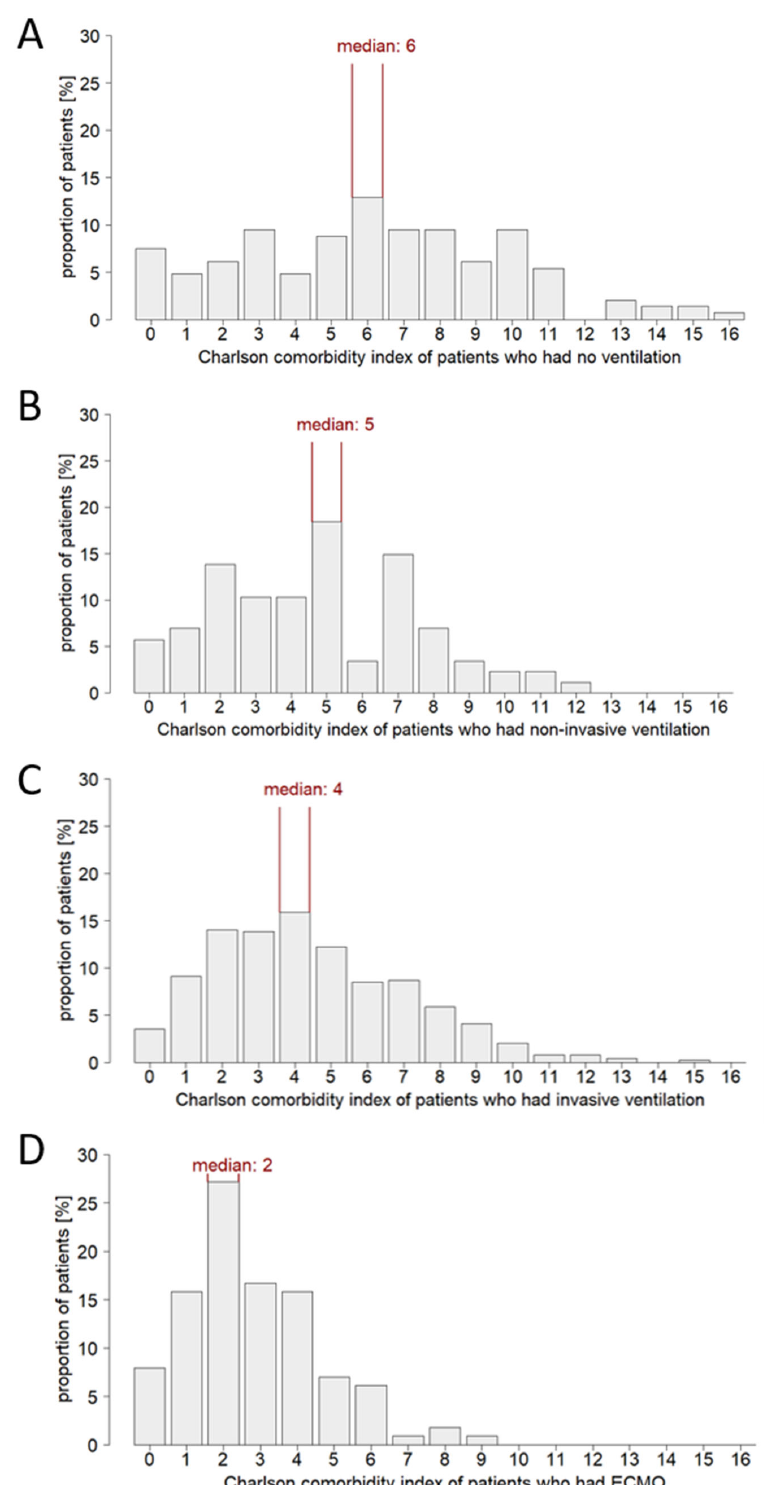
Figure 3. Distribution of the Charlson comorbidity index in COVID-19 patients receiving intensive care. ( A ): Sub-cohort of non-ventilated patients ( n = 147), ( B ): sub-cohort of non-invasively ventilated patients ( n = 87), ( C ): sub-cohort of invasively ventilated patients ( n = 492), ( D ): sub-cohort of ECMO patients ( n = 114).